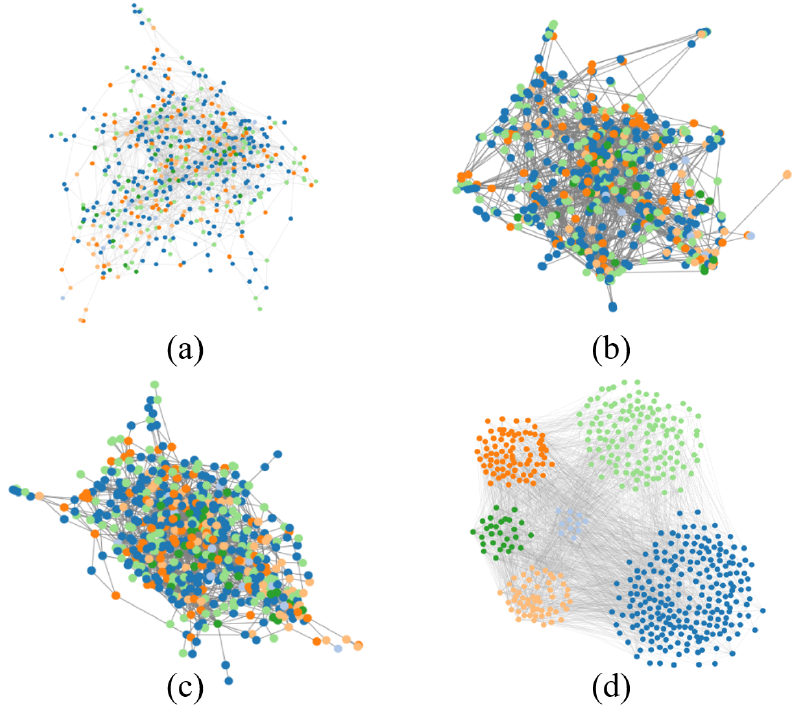
Figure 7. The result of attribute community layout under the attribute ‘Number of Citations’. ( a ) FR layout; ( b ) LinLog layout; ( c ) ForceAtlas2 layout; ( d ) layout of our